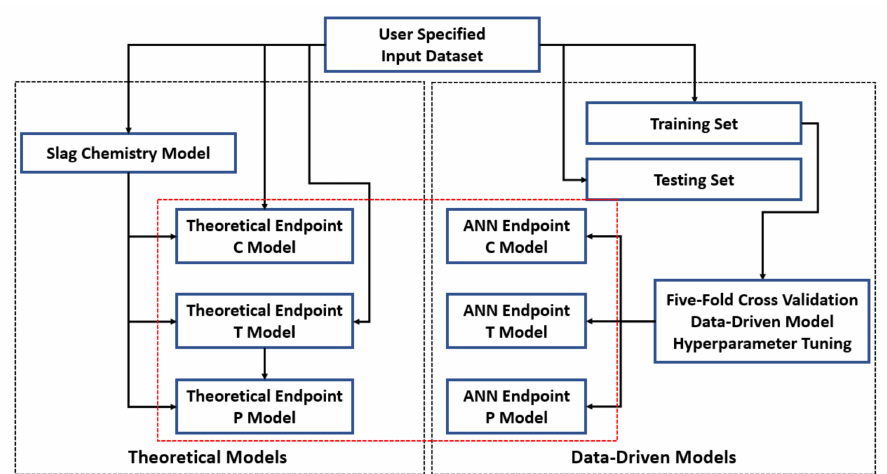
Figure 1. Flowchart of the development for theoretical models and data-driven models, models highlighted in red correspond to the participants in hybrid